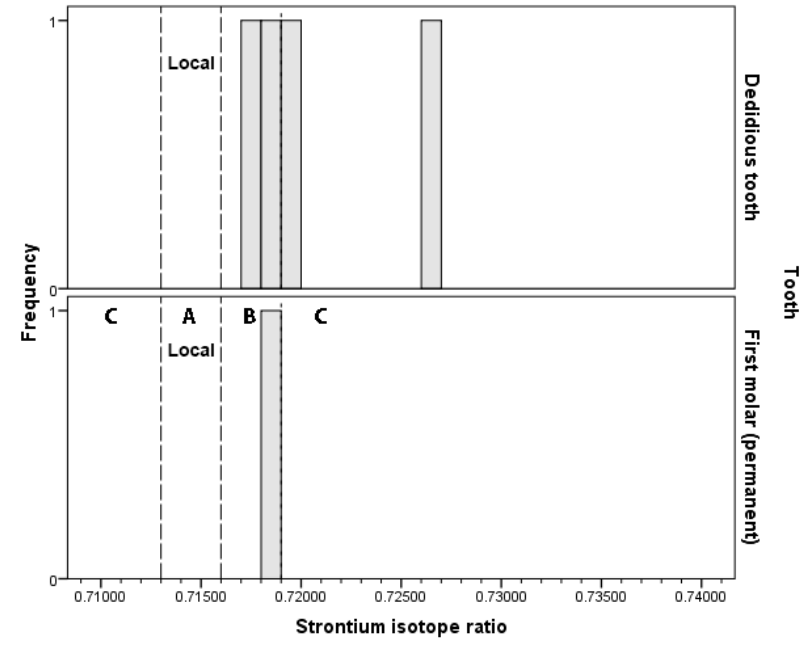
Figure 13. Histogram of strontium isotope ratios of children and juveniles with unknown sex, Falköping stad 5. A: Local 87 Sr/ 86 Sr ratios, B: non-local/mixed 87 Sr/ 86 Sr ratios, C: non-local 87 Sr/ 86 Sr ratios, see text above. The local and non-local signals of Falbygden are based on earlier and ongoing